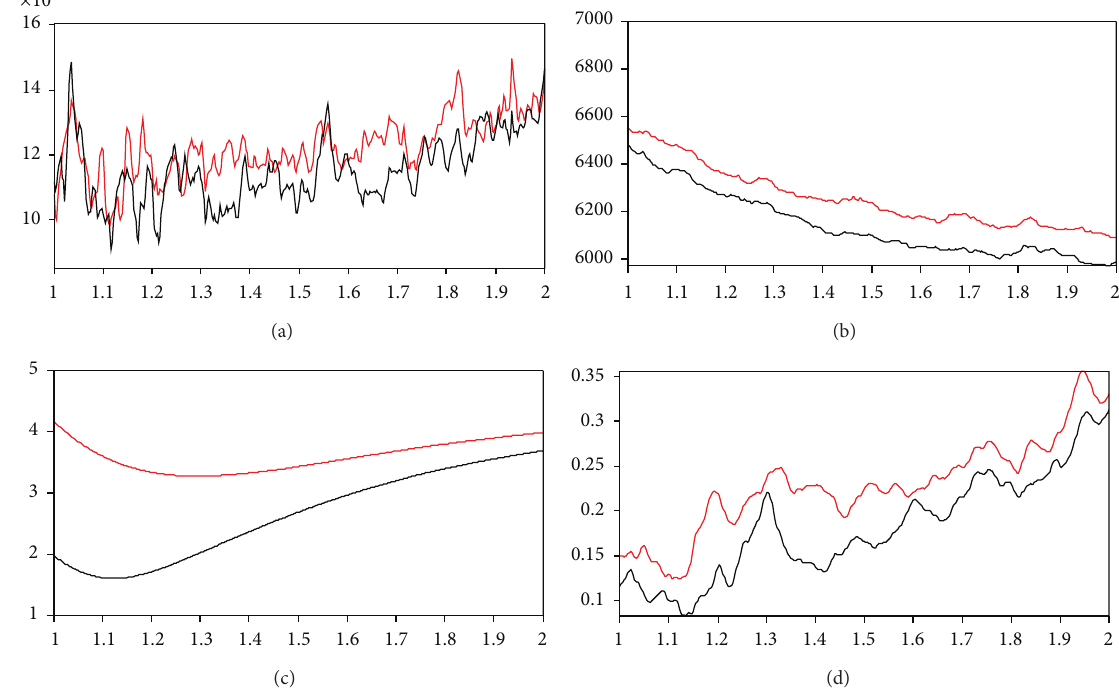
Figure 14: Forecasted time series of RMSEs of (a) atmospheric stream function, (b) oceanic stream function, (c) sea surface temperature, and (d) land surface temperature for GDF (black curve) and DF with 𝑎, 𝑏 = 0.5 (red